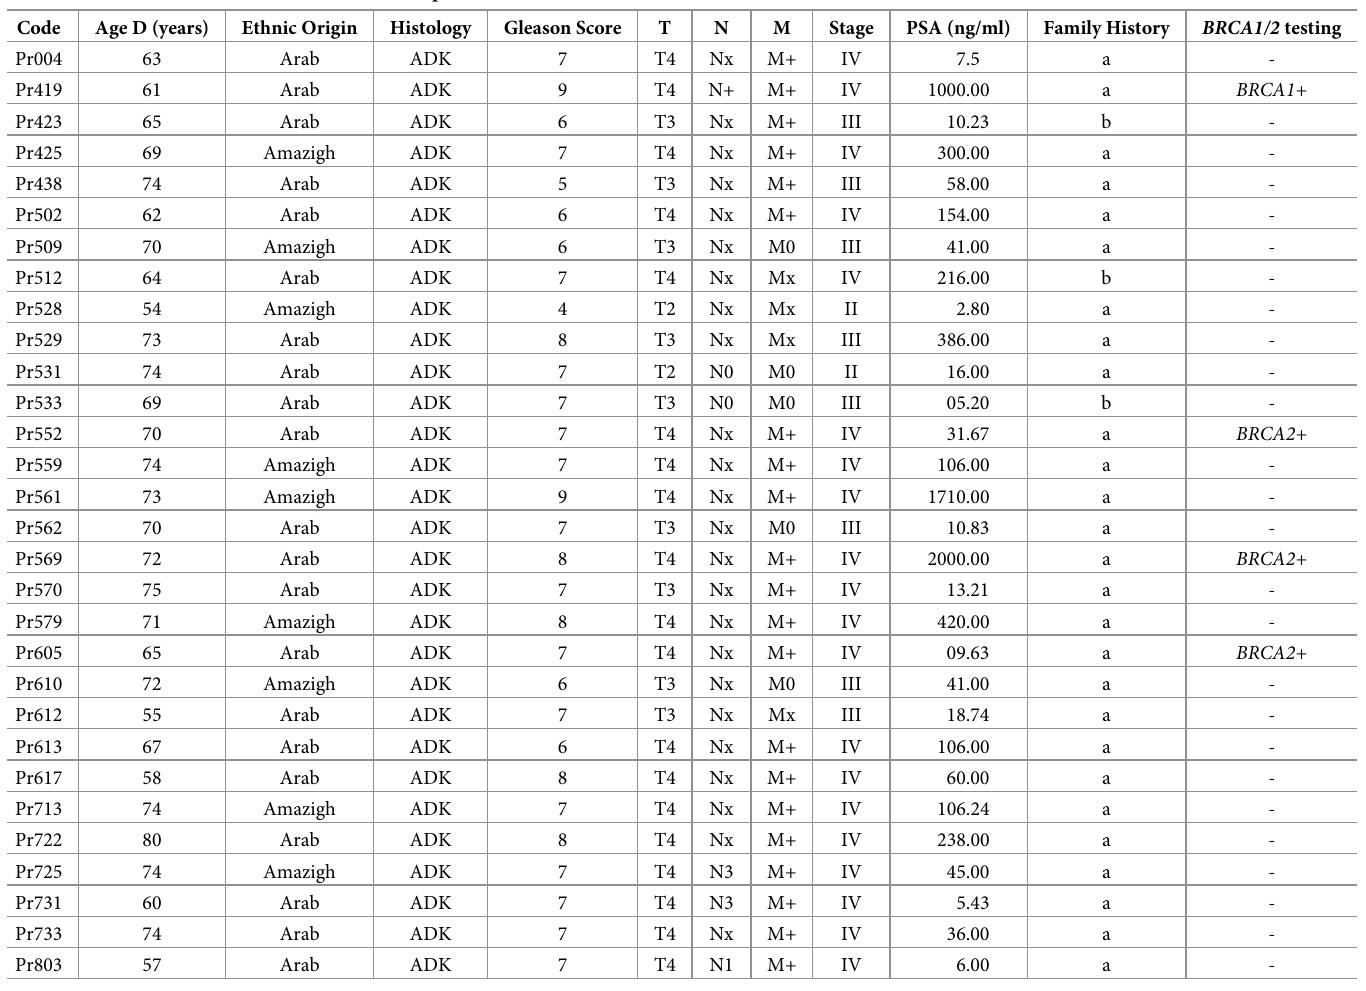
Table 1. Characteristics of studied Moroccan PrCa patients.